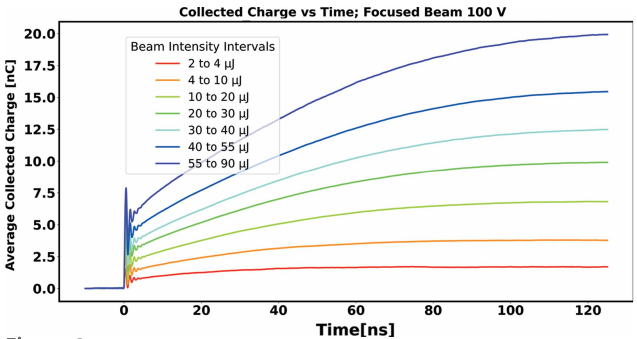
Figure 9 Collected charge as a function of collection time for a sensor bias of 100 V, with the beam focused to a FWHM of 43 m m.